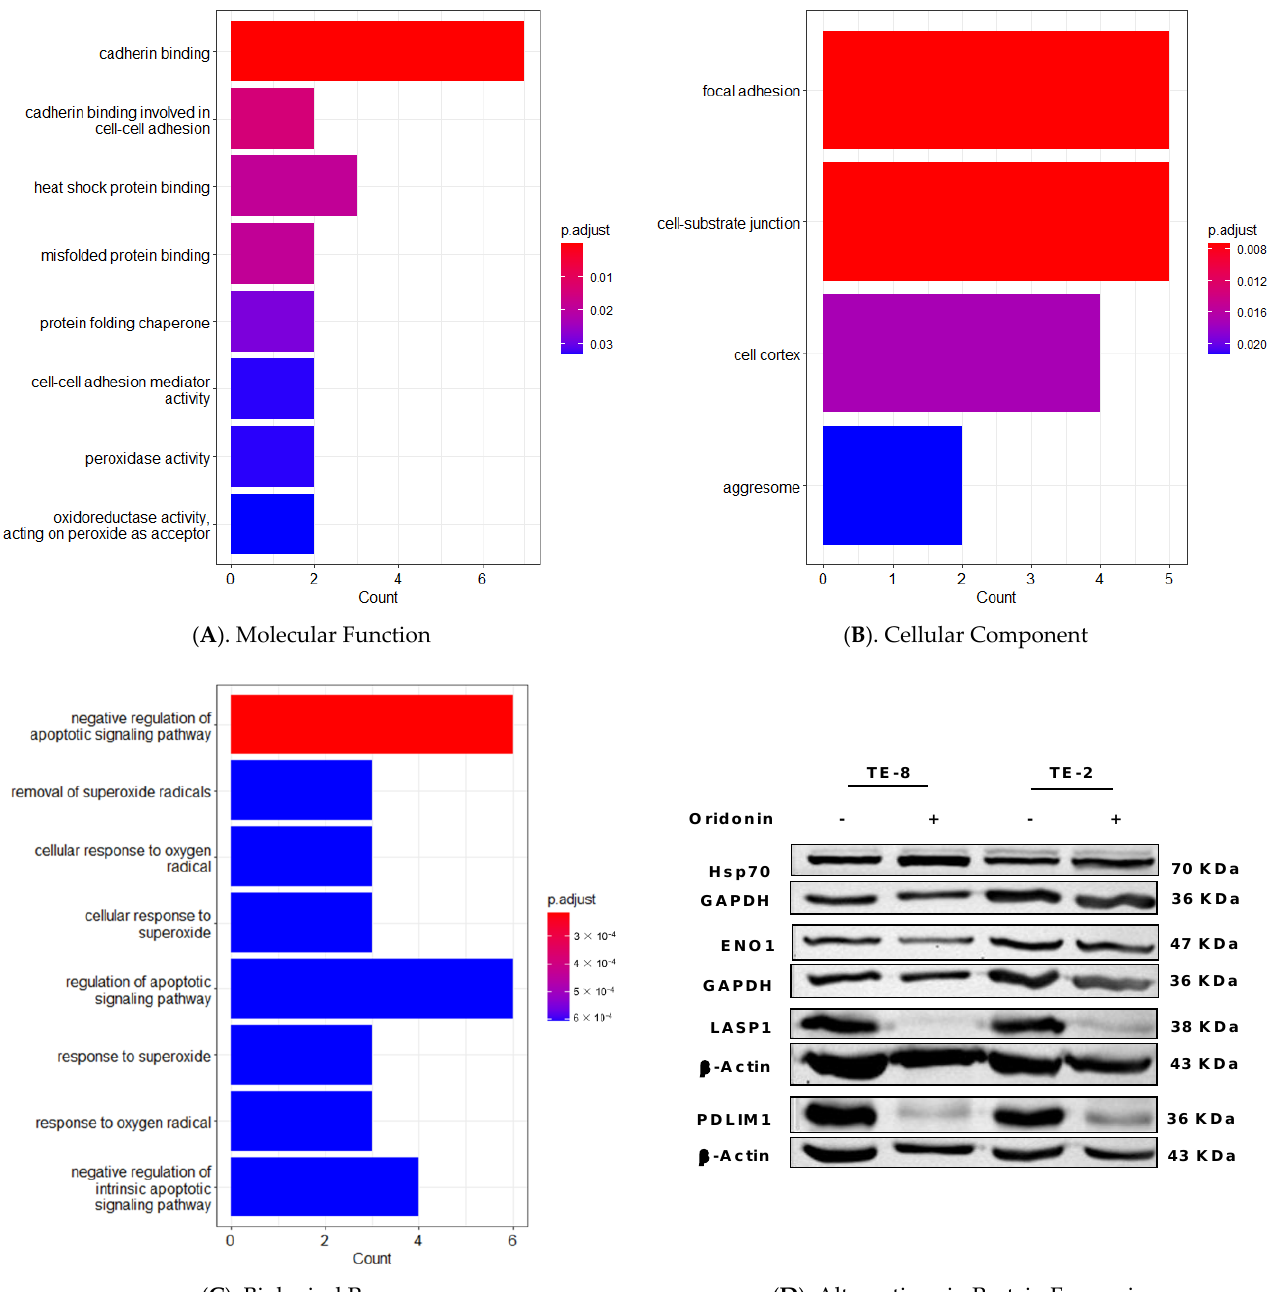
Figure 6. Gene Set Enrichment Analysis and western blotting assessed that oridonin inhibits LASP1 and PDLIM1 on ESCC. ( A ) Molecular function classification of the protein candidates involved in oridonin treatment. The top three are cadherin binding, cadherin binding involved in cell – cell ad- hesion, and heat shock protein binding. ( B ) The top three cellular component classifications are focal adhesion, cell-substrate junction, and cell cortex. ( C ) The top three biological processes are negative regulation of apoptotic signaling pathway, removal of superoxide radicals, and cellular response to oxygen radicals. ( D ) Protein expression of LASP1 and PDLIM1 under oridonin treatment decreased compared to untreated cell lysates. Hsp70 expression increased in oridonin-treated cell lysates com- pared to untreated while ENO1 decreased a little in treated TE-8.